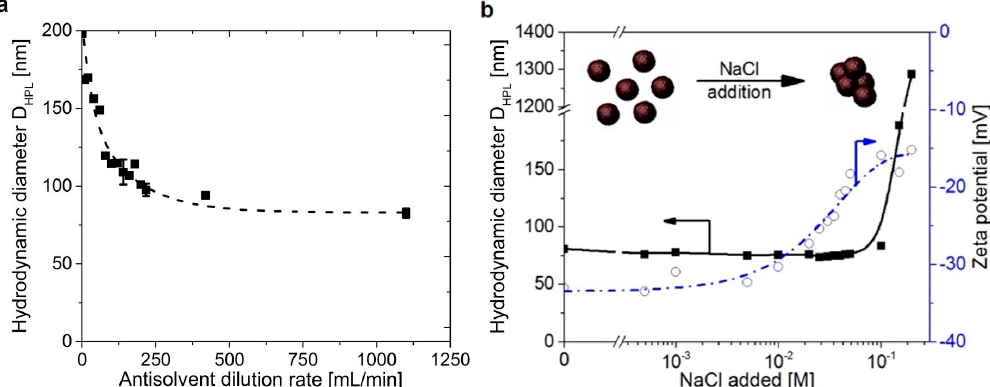
Figure 2. ( a ) Influence of the dilution rate on the Organosolv lignin (OS) particle diameter at initial lignin concentrations of 1 wt %; ( b ) Influence of the ionic strength on particle diameter and ζ -potential by addition of NaCl. Reprinted with permission from Richter et al. [43]. Copyright 2016 American Chemical Society.